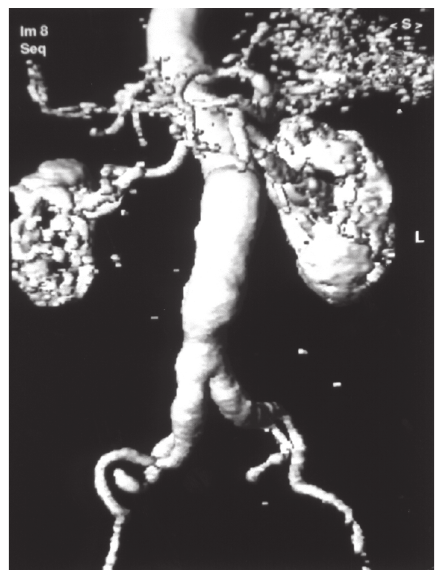
Figure 6 - Nuclear magnetic resonance imaging of an abdominal aortic aneurysm – longitudinal reconstruction.